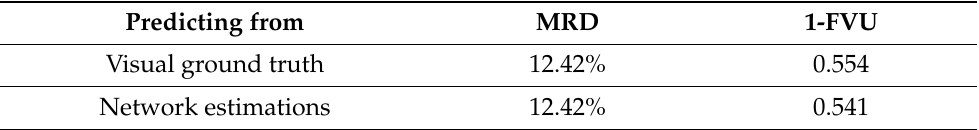
Table 5. Prediction of actual banana fruits count per bunch based on visual ground truth count, and based on network